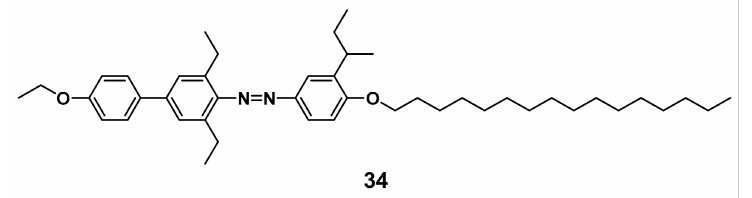
Figure 16. The molecular structure of 34 .